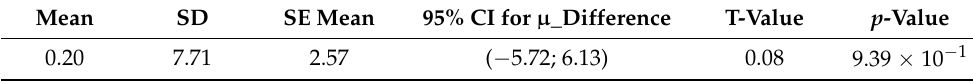
Table 8. Mean cutting force values with standard deviations.